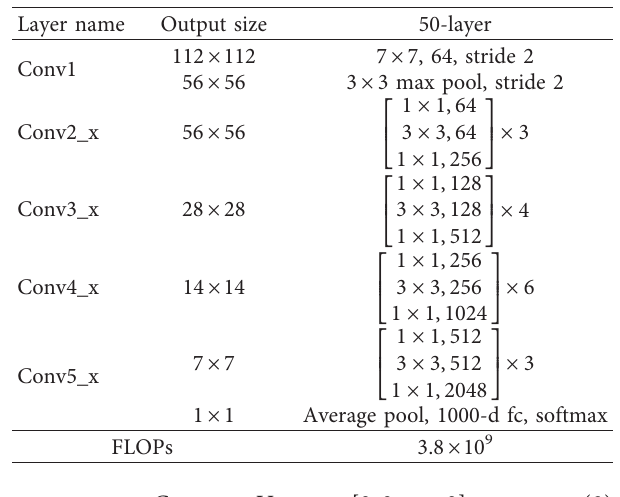
Figure 5: A comparison of two projection methods. Table 1: The structure of